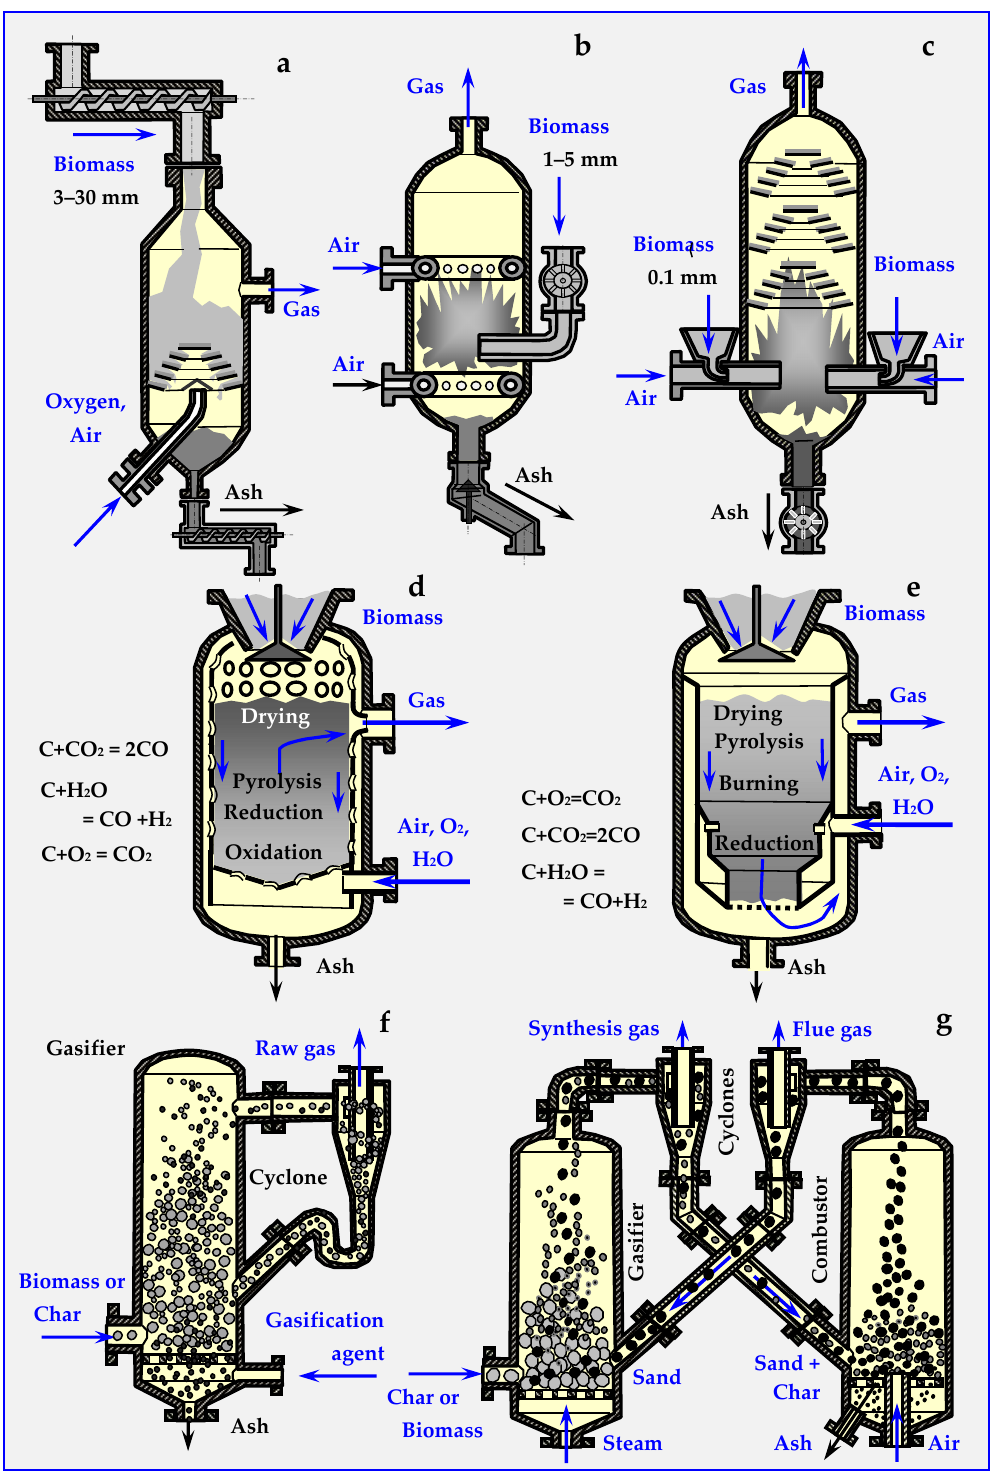
Figure 19. Types of gasifiers based on descriptions from papers [17,133–135,143,149–152]: ( a ) flow, grate with screw feeders, ( b ) with a fluidized bed and conical and butterfly gate valves, ( c ) stream with a pneumatically dosed bed, ( d ) counter-current (updraft) with a fixed bed, ( e ) co-current (downdraft) with a fixed bed, ( f ) Lurgi Circulating Fluidized Bed for biomass gasification and ( g ) fluidized bed for biomass